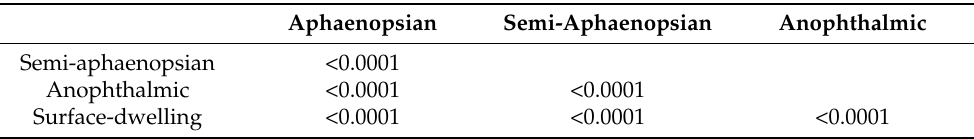
Table 3. P -values of the differences in Mahalanobis and Procrustes distances for the four adaptive types of ground beetles (10,000 permutation test, consistent for the head, pronotum, and